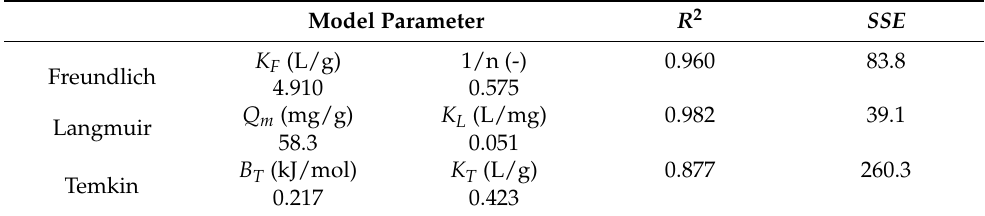
Figure 4. Equilibrium adsorption results for Sb(V) adsorption by Fe-CMB and model fits using Freundlich, Langmuir, and Temkin models. Table 3. Model parameters and model suitability for equilibrium adsorption data obtained from Freundlich, Langmuir, and Temkin models.